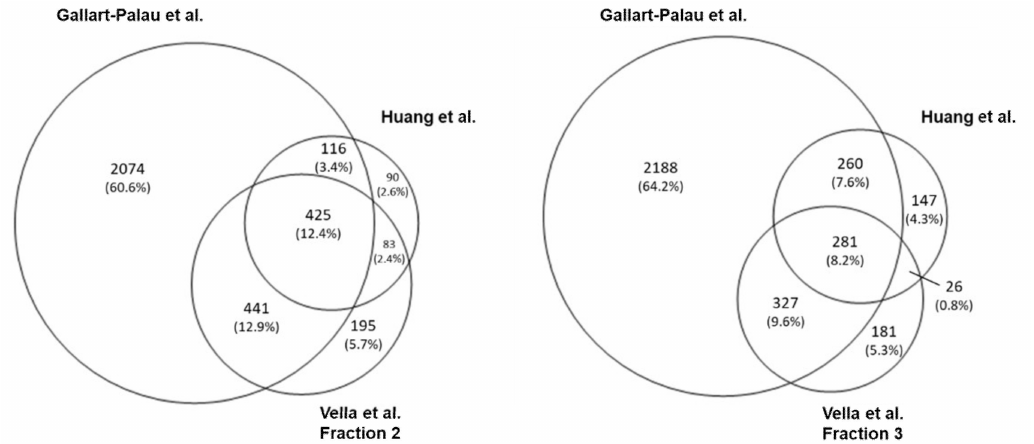
Figure 4. Venn diagram of all proteins detected in human studies. On the left, the Venn diagram for human studies including Vella et al. fraction 2. On the right, including Vella et al. fraction 3. Gallart-Palau et al. detected 60.6% of proteins as unique, sharing 12.9% of proteins with the data set of fraction 2 from Vella et al., and 3.4% with Huang et al. The latter detected 2.6% of proteins as unique while sharing with Vella’s fraction 2 the 2.4% of detected proteins. Fraction 2 from Vella et al. accounts the 5.7% of proteins as unique. 12.4% of all proteins are shared among the three studies. When considering Vella’s fraction 3, Gallart-Palau et al. detected 64.2% of proteins as unique, sharing 9.6% of proteins with the data set of fraction 3 from Vella et al., and 7.6% with Huang et al. The latter detected 4.3% of proteins as unique, sharing with Vella et al. fraction 3 0.8% of proteins detected. Fraction 3 from Vella et al. presents 5.3% of proteins as unique. 8.2% of all proteins are shared among the three